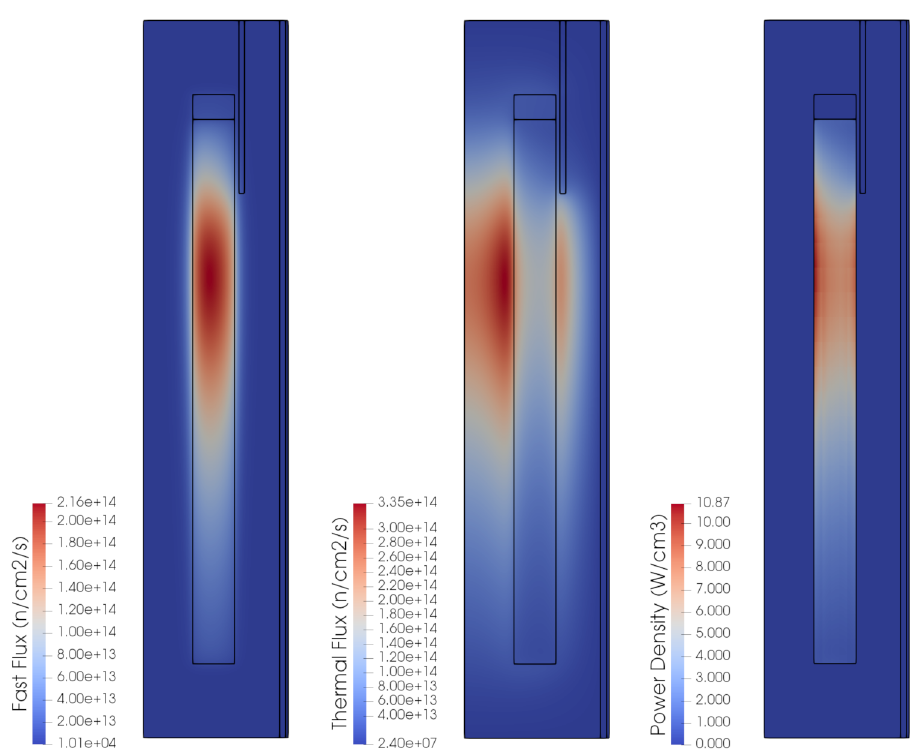
Figure 2: 2D Results - Fast Flux, Thermal Flux, Power